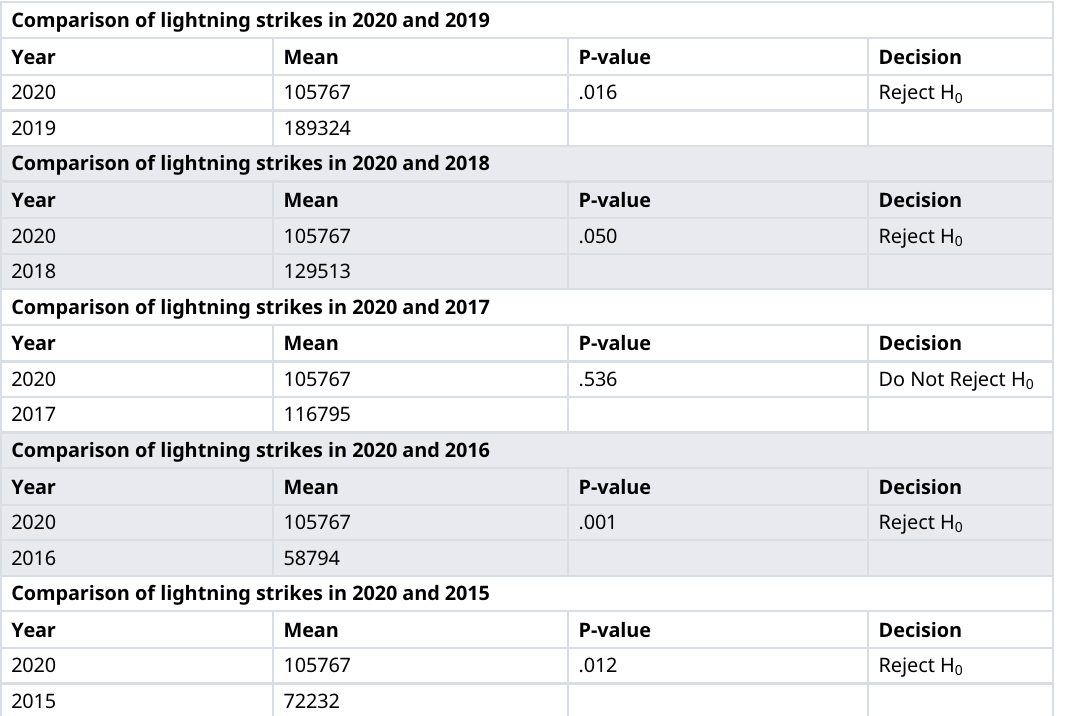
Table 7. t-test results comparing lightning strikes in 2020 with previous years in